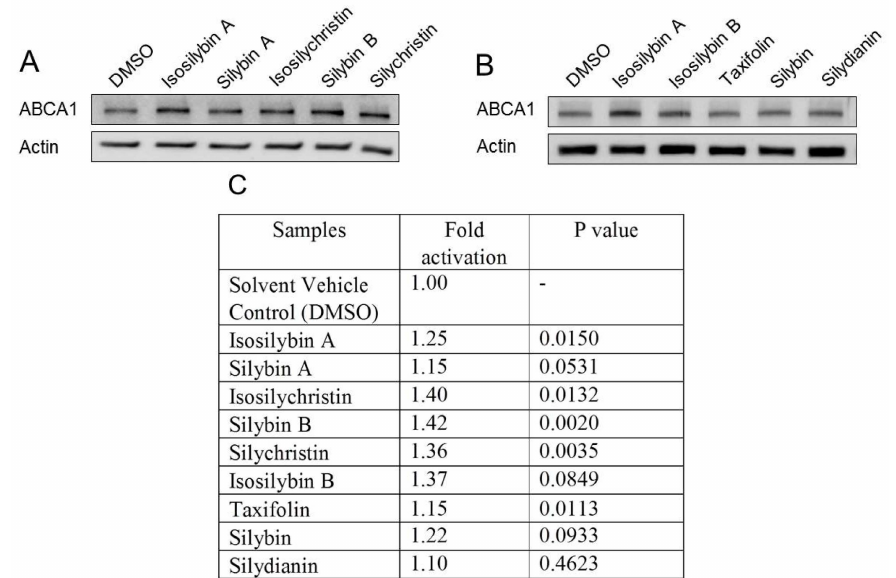
Figure 4. Effect of the investigated compounds on ABCA1 protein levels. Western blot analysis shows ABCA1 protein expression levels. THP-1 macrophages were treated with solvent control (DMSO) or the investigated compounds (10 µ M). After 24 h incubation, cells were lysed and proteins analyzed via SDS-PAGE. ( A ) presents the compounds silybin A, isosilychristin, silybin B and silychristin; ( B ) presents the compounds isosilybin B, taxifolin, silybin and silydianin. Experiments are independently performed three times, and representative images are shown; The summarized results from the quantification of all performed experiments are presented in ( C ). All values are mean ( n = 3) compared to the solvent vehicle control (DMSO), two-tailed t -test was used for